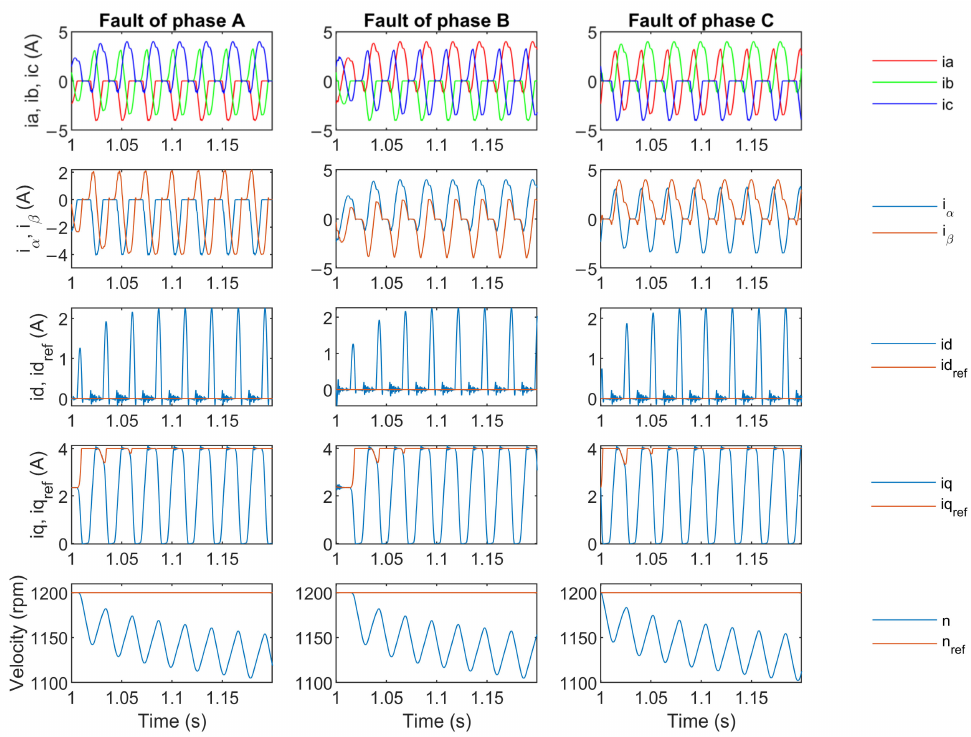
Figure 6. First 4000 samples of simulation after the fault of the upper switch at phase A, B, or C of the 6S3P topology.